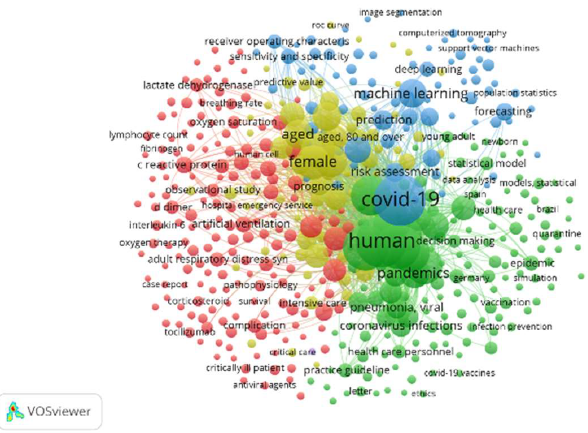
Figure 8. Visualization of the co-word network in the research topic “AI applied to COVID-19”.